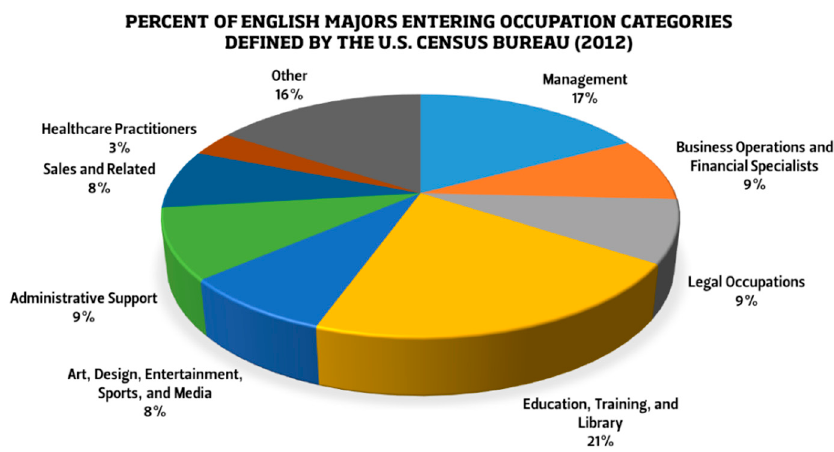
Figure 1. Source: https://liberalarts.oregonstate.edu/what-careers-do-english-majors-pursue. See (OSU n.d.).